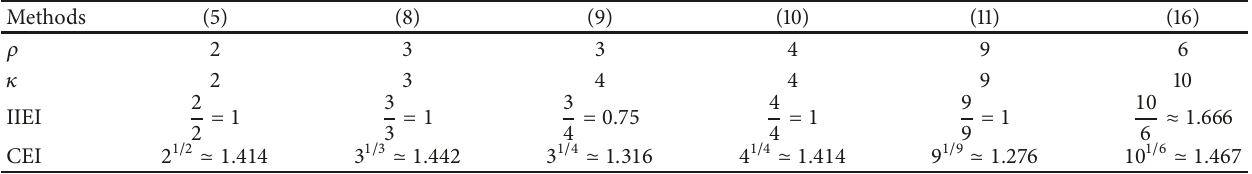
Table 1: A comparison on the calculational burdensome of various methods applying different indices.